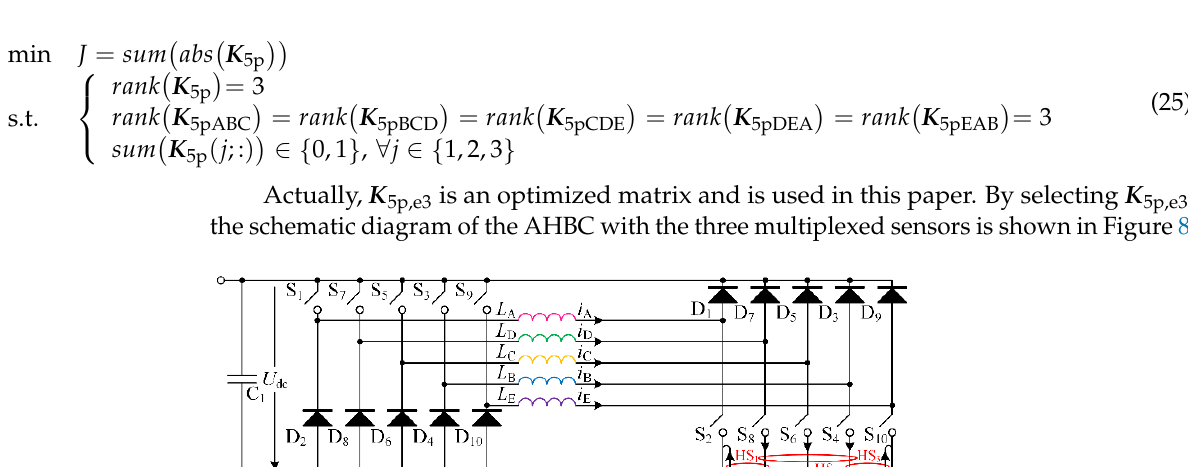
Figure 8. AHBC with three multiplexed current sensors for a five-phase SRM.